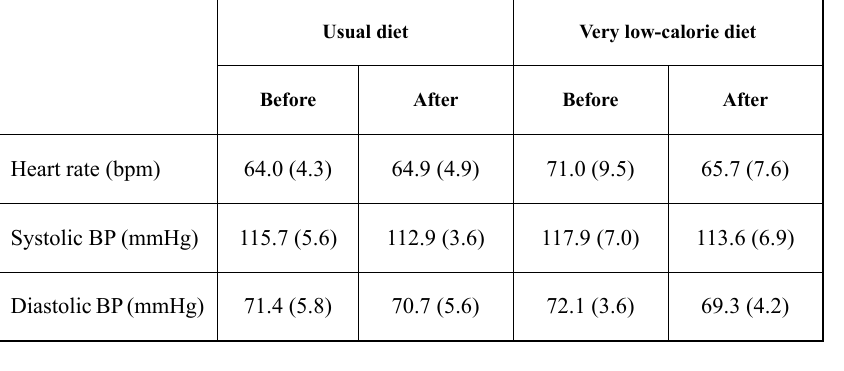
Table 2. Effect of a 2-day very low-